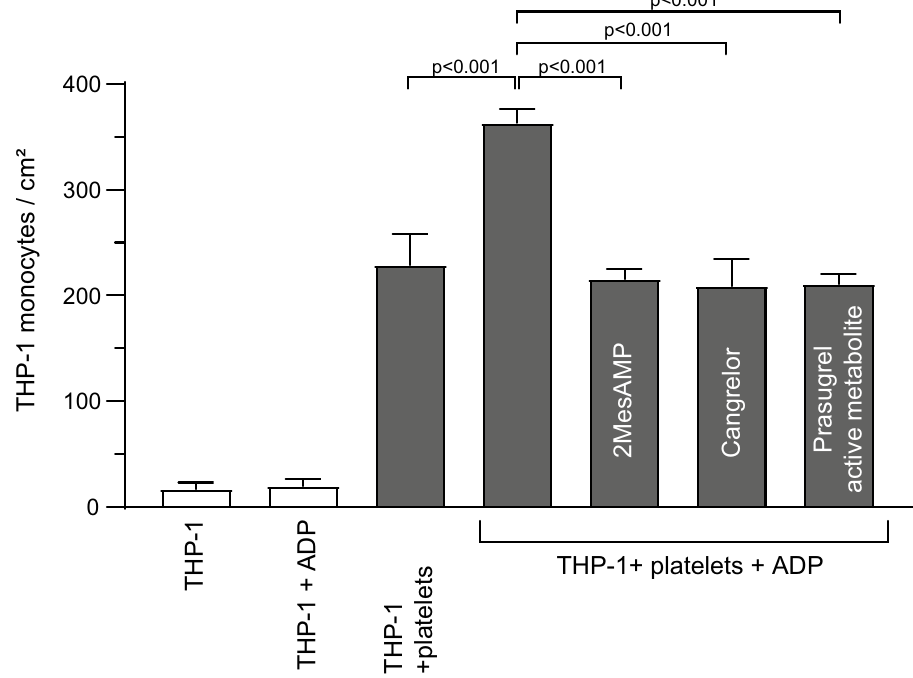
Figure 3. ADP-stimulated monocyte platelet aggregates bind to ICAM-1 under shear flow. Flow chamber experiments were conducted as described in the “Methods” section. The number of adhering THP-1 monocytes/ cm 2 as determined under a microscope using a Neubauer chamber is presented. THP-1 cells alone either with or without ADP stimulation did not bind to ICAM-1. However, THP-1 monocytes pre-incubated with platelets demonstrated binding to ICAM-1 and this binding was increased with ADP stimulation. This increase could be inhibited by the addition of P 2 Y 12 receptor blockers (2MesAMP, cangrelor and prasugrel active metabolite). n = 5, data are presented as mean ± SEM. p -values were calculated using one-way ANOVA and a Tukey’s multiple comparison